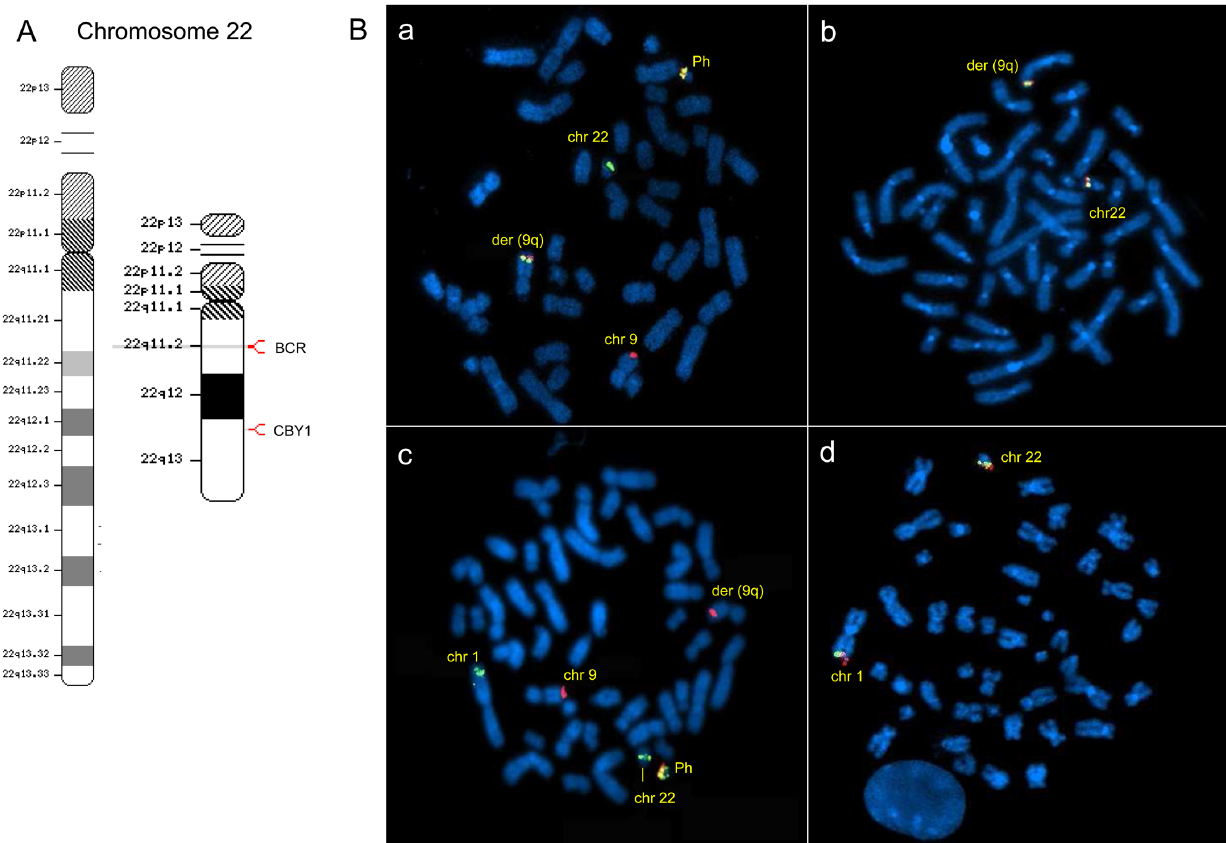
Figure 1. C22orf2 , the Cby1-encoding gene, follows BCR sequences and relocates to the der(9q) or third chromosome involved in variant translocations. A- Location of BCR and Cby1 genes on chromosome 22 are shown with red marks on chromosome 22 ideogram using NCBI Map Viewer (http://www.ncbi.nlm.nih.gov/mapview/). B- panel a: typical FISH pattern of BCR-ABL1 rearrangement with one fusion signal at der(22q), one green signal at the non-rearranged 22q, and one red signal at 9q in the metaphases of a CP-CML patient with t(9;22) translocation; panel b: one pair of Cby1 signals, with the green one labeling the promoter origin and the red one the end of the gene, was translocated to der (9q) in metaphases of a CML-CP patient with t(9;22) translocation; panel c: the green signal corresponding to BCR was relocated to chromosome 1 in one patient exhibiting the t(1;9;22) variant translocation ( # 9 of Table S1); panel d: in the last case, Cby1 signals were relocated at the third chromosome involved in translocation. The results shown in panel b were confirmed in CML-CP patients with t(9;22) translocation included in the study, and those shown in panel d were confirmed in two CML-CP patients with variant translocations encompassing chromosomes 1 and 7 (see Figure S2). All images were acquired using a 100 6 objective. FISH analyses were performed according to procedures illustrated in the Materials and Methods section. At least 20 metaphases were analyzed for the detection of BCR-ABL1 and C22orf2 signals.